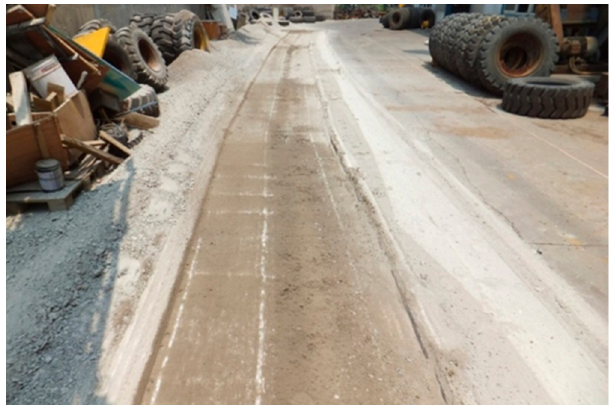
Figure 10. The field test of the cold milling machine.